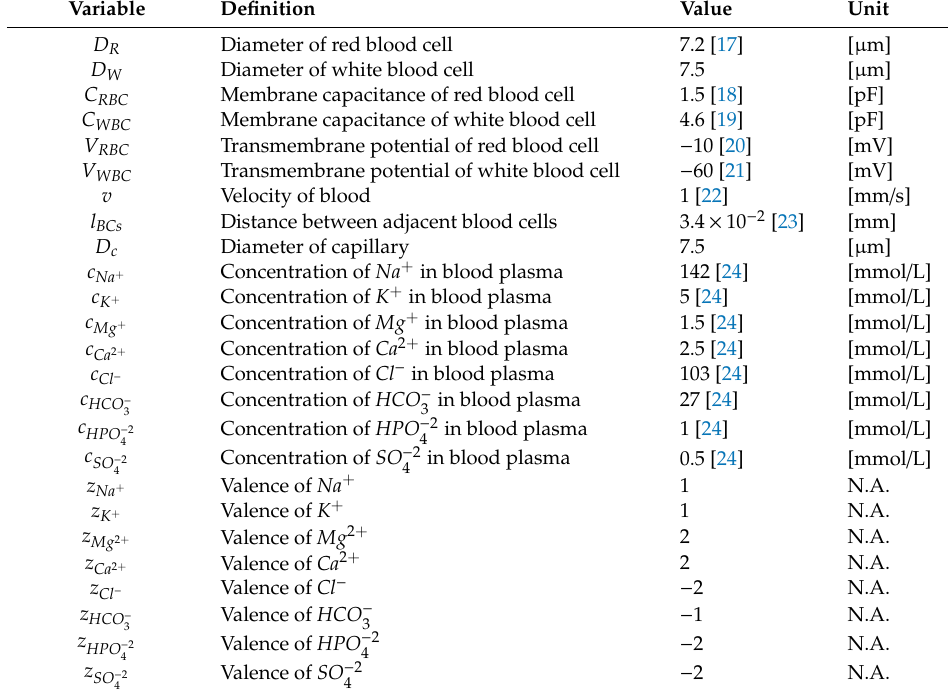
Table 1. Definitions of variables and values used in the magnetic microcoil for blood cell